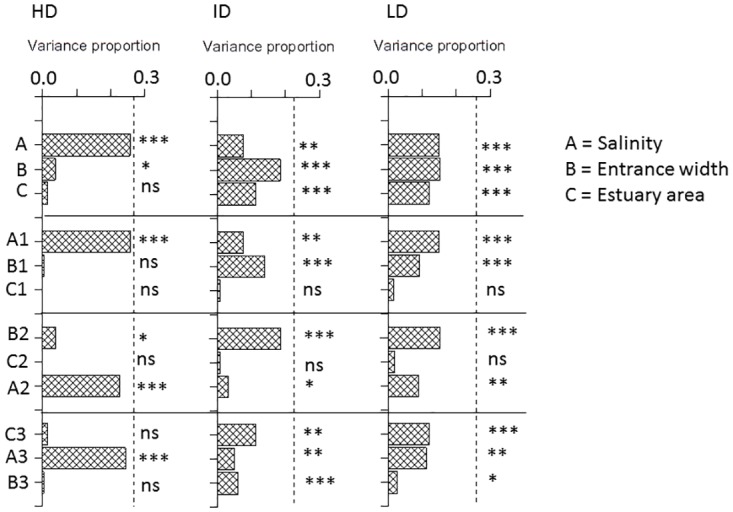
Results of marginal and sequential tests in DistLM modeling of βsim with three predictors (A = Salinity difference, B = Log10 Entrance width difference and C = Log10 Estuary area difference) of paired samples from different estuaries.HD = High dispersive, ID = Intermediate dispersive and LD = Low dispersive species trait group. Variance proportion = the proportion of total variance explained by the predictor (S2). Top sequence (A,B,C) shows results from marginal tests and the following three sequences (A1,B1,C1 and B2,C2,A2 and C3,A3,B3) show results from sequential tests, where A1, B2 and C3 are first fitted to data and B1,C1,C2,A2, A3, B3 gives the remaining independent variance explained after the previous variable has been fitted. Dashed vertical line indicates the total variance proportion explained by the variables. *** = P = 0.001, ** = P <0.01, * = P < 0.05 and ns = P > 0.05.